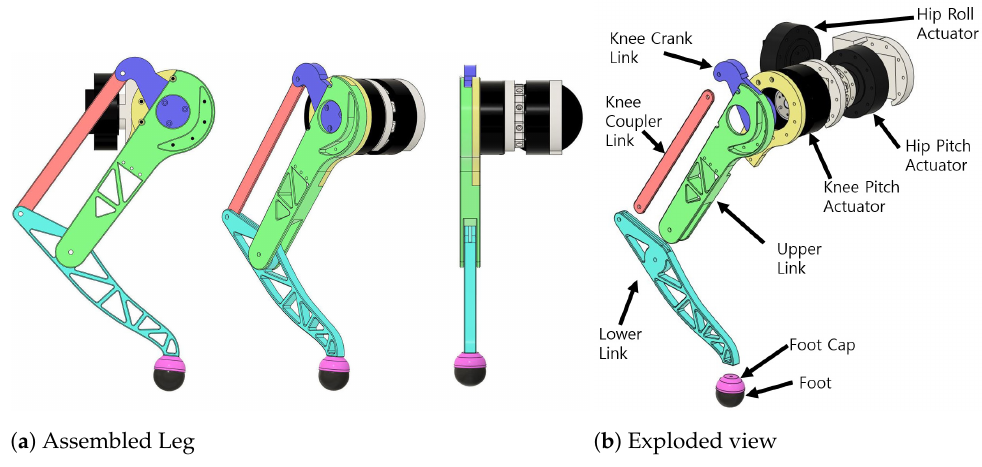
Figure 6. 3DOF Leg with a parallelogram linkage.